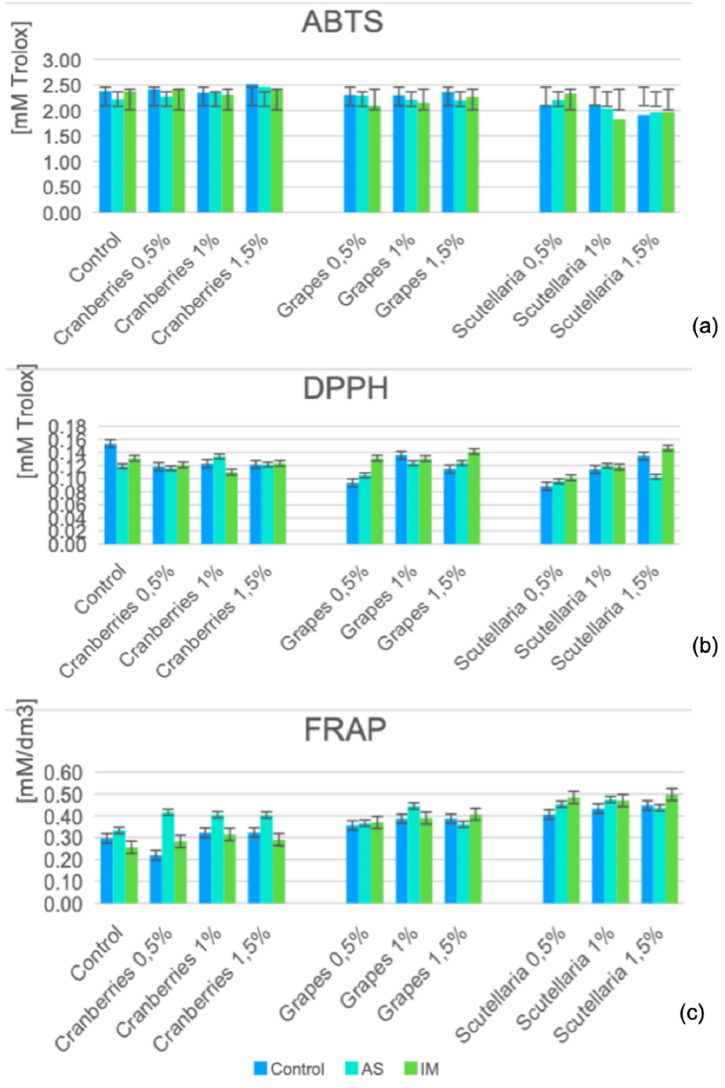
Figure 2. Changes in ( a ) ABTS, ( b ) DPPH, and ( c ) FRAP values across the various marinated oven-grilled chicken breast meat samples compared to a control. The marination variants involved cranberry pomace (“Cranberries” in Figure), grape pomace (“Grapes” in Figure) and Baikal skullcap (“Scutellaria” in Figure) that incorporated either African spice (AS) or industrial marinade/pickle (IM). Results are expressed as mean ± standard deviation (SD) at the probability level of p < 0.05. ABTS: 2,2’-Azinobis-(3-ethylbenzthiazoline-6-sulphonate); DPPH: 1,1-diphenyl-2-pierylhydrazy (radical scavenging activity); FRAP: ferric-reducing antioxidant power. Further, the ABTS, DPPH, and FRAP values would not necessarily align with either the CP, GP, or BS concentration increments despite their individual antioxidant potentials.